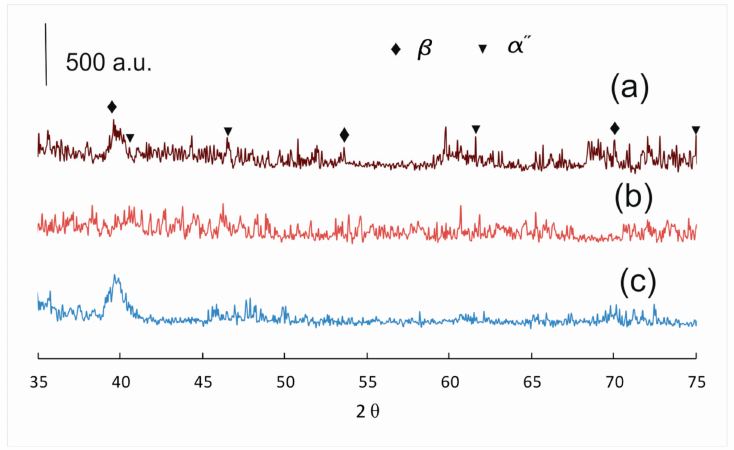
Figure 4. XRD patterns of the Ti-Nb-Zr-Ta-Fe-O alloy in: ( a ) as-cast, ( b ) HSHPT- and ( c ) HSHPT + CR- processed